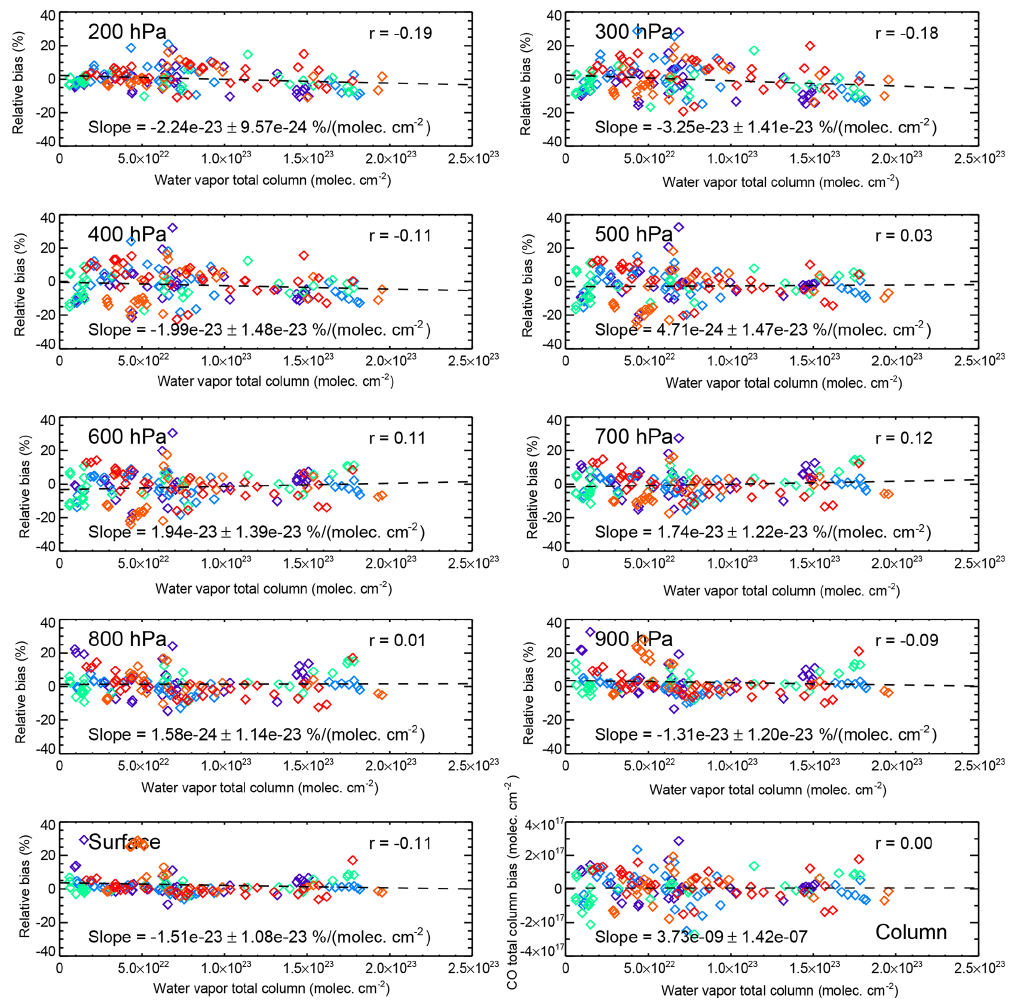
Figure 7. Dependence of V8 TIR-only biases on water vapor total column, based on the HIPPO CO profiles. Colors indicate the particular phase of the HIPPO mission, as described in the caption to Fig.